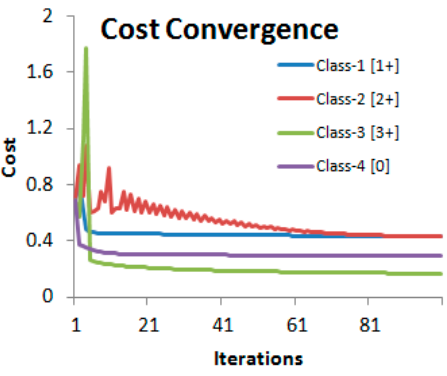
Figure 8. Convergence of the cost functions of the four-class logistic regression algorithm. Reproduced from [12] with permission. Table 4. Confusion matrix for the multi-class logistic regression algorithm. Reproduced from [12] with permission.